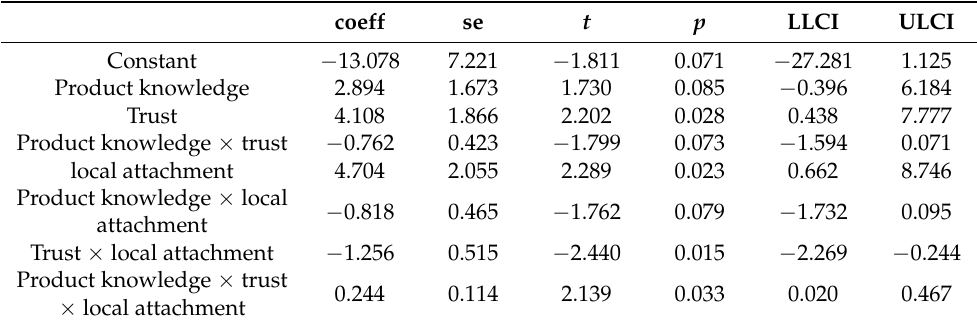
Table 6. Three-way interaction model of multiplication of local attachment and trust in product knowledge and purchase intention.